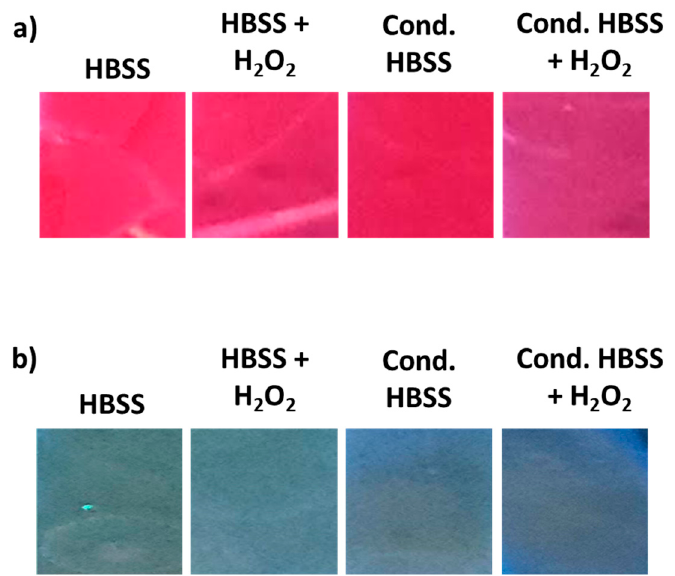
Figure 8. Real color images of a cropped area of the model complex—reported in Figure 5—( a ) and complex 1 ( b ) loaded in sol-gel matrices after adding cell-conditioned HBSS media. Matrices treated with non-conditioned HBSS (HBSS); non-conditioned medium +800 μ M H 2 O 2 (HBSS+ H 2 O 2 ); cell- conditioned HBSS (Cond. HBSS); and cell-conditioned HBSS after 1 h treatment of the HepG2 cells with 800 μ M H 2 O 2 (Cond. HBSS+ H 2 O 2 ).